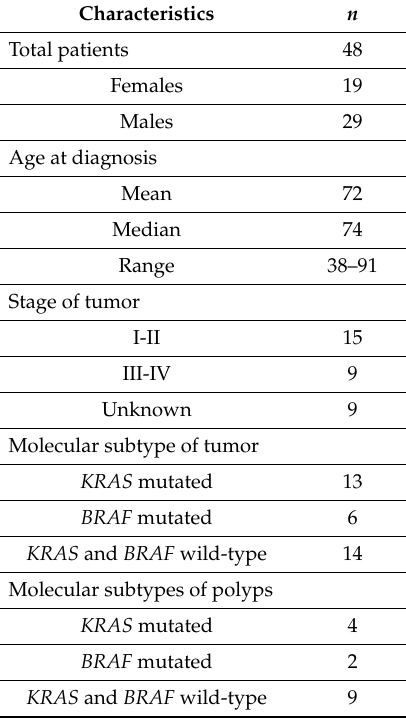
Table 2. Clinicopathological patient characteristics of the colon cancer and polyps